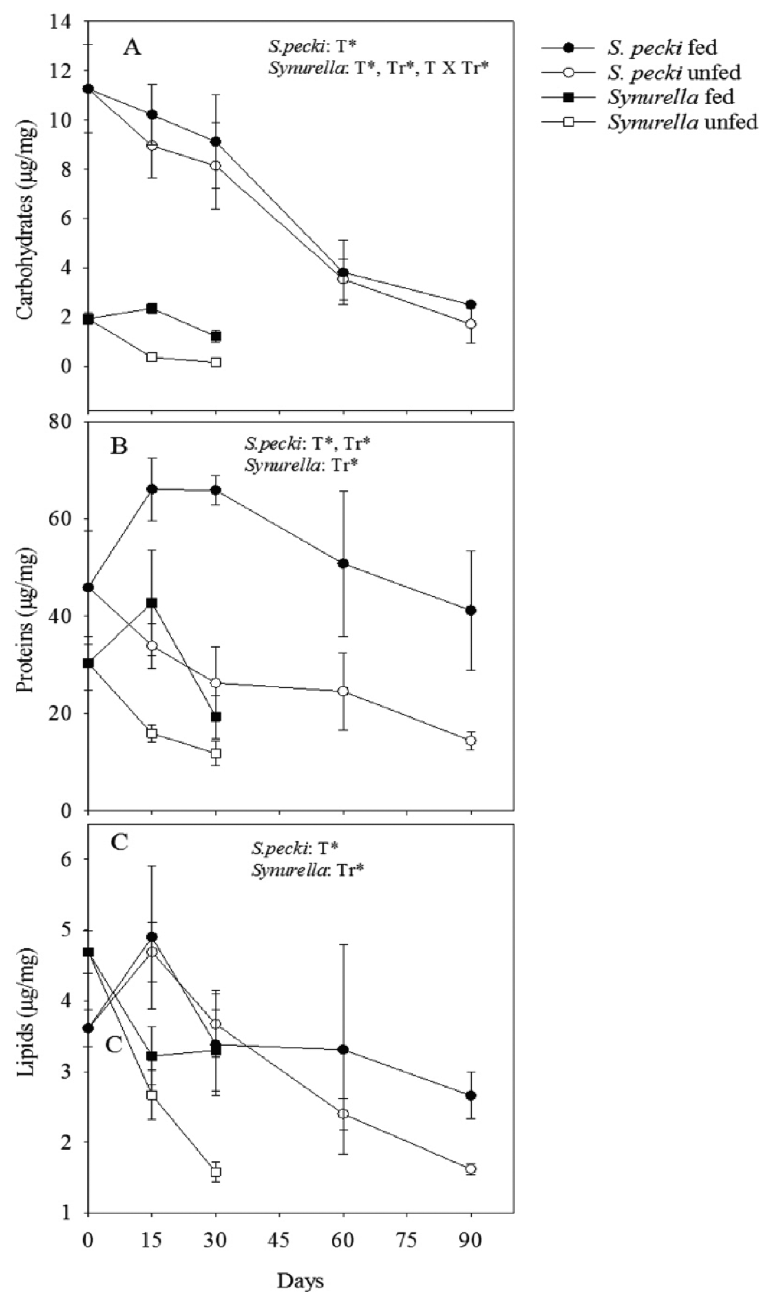
Figure 2. Changes in the levels of body metabolites in Stygobromus pecki and Synurella sp. A Carbohy- drates B proteins C lipids concentrations during long-term food deprivation at 23 °C in darkness. Values are means ± SEM for n = 5 replicates. (* ) indicates significance at P < 0.05 for the main effects of Treat- ment, Time and the Time × Treatment